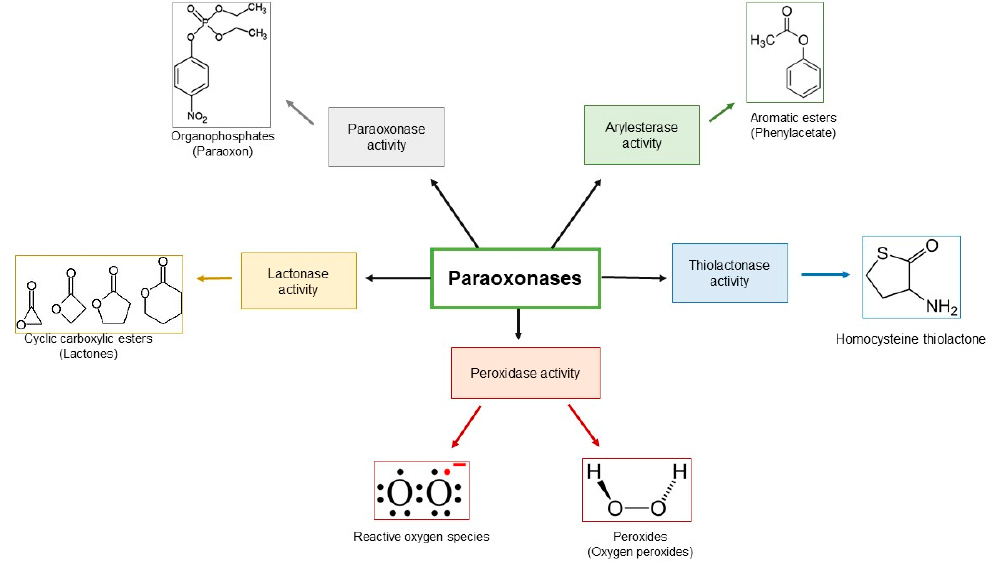
Figure 1. Paraoxonases activities and substrates.